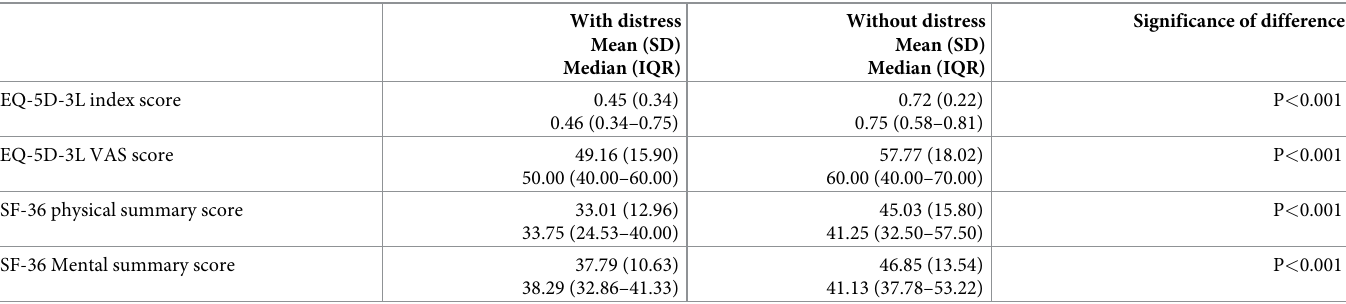
Table 6. Known group comparison among participant with or without psychological distress with SF-36 summary scores and EQ-5D-3L scores.